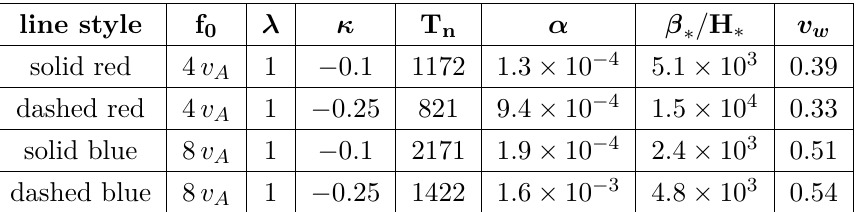
Table 3. Test points for the UV agnostic TH. The corresponding GW spectra are plotted in figure 9(a).